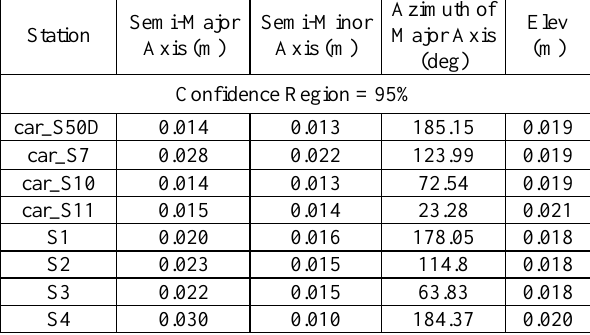
Table 4. Error ellipses parameters after